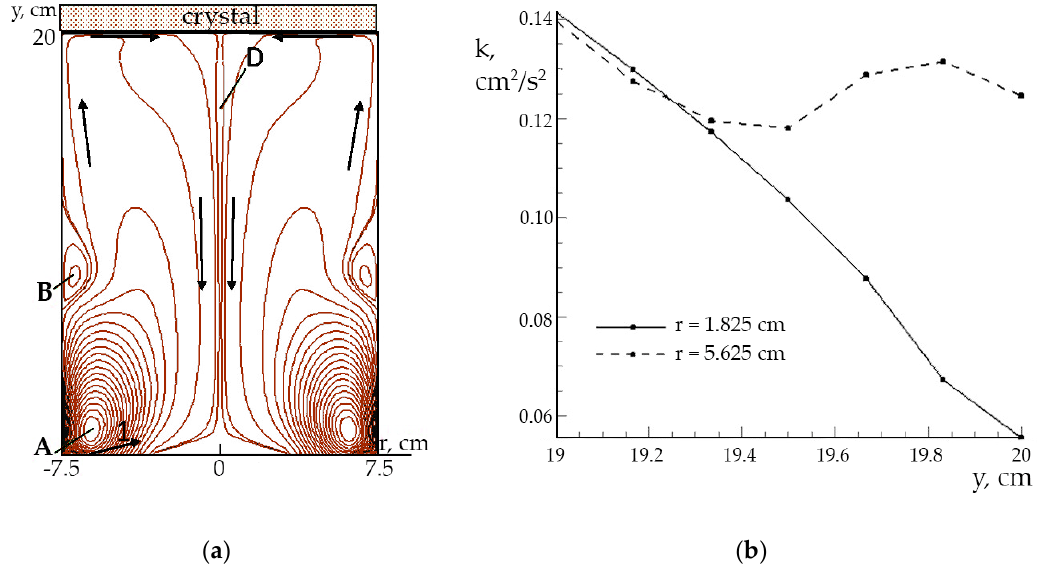
Figure 7. The turbulent flow during a peripheral solution supply: ( a ) streamlines of turbulent flow; ( b ) profiles of the kinetic flow energy k (y) for longitudinal sections in the boundary layer.